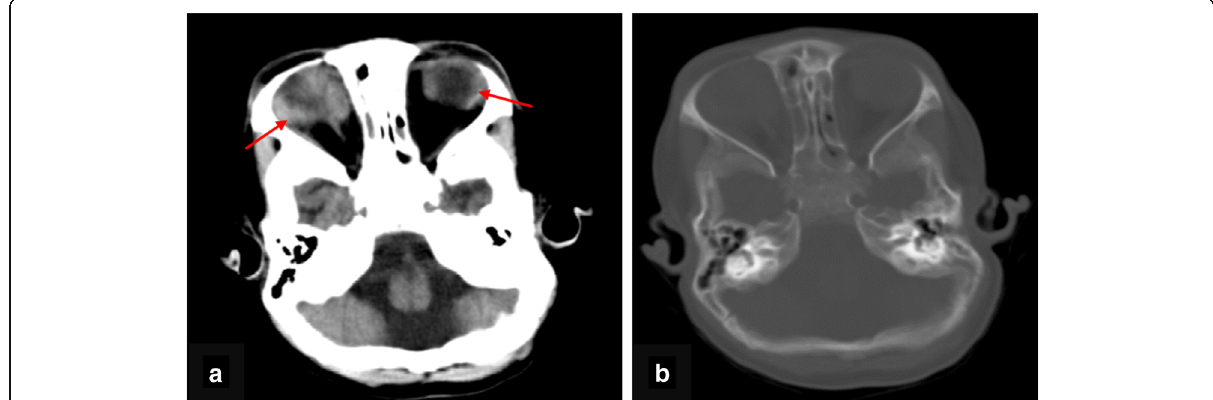
Fig. 2 a , b Axial section of NCCT head in soft tissue and bone window confirms absence of fracture and heterogeneously hyperdense extraconal content, more on right side as compared to left